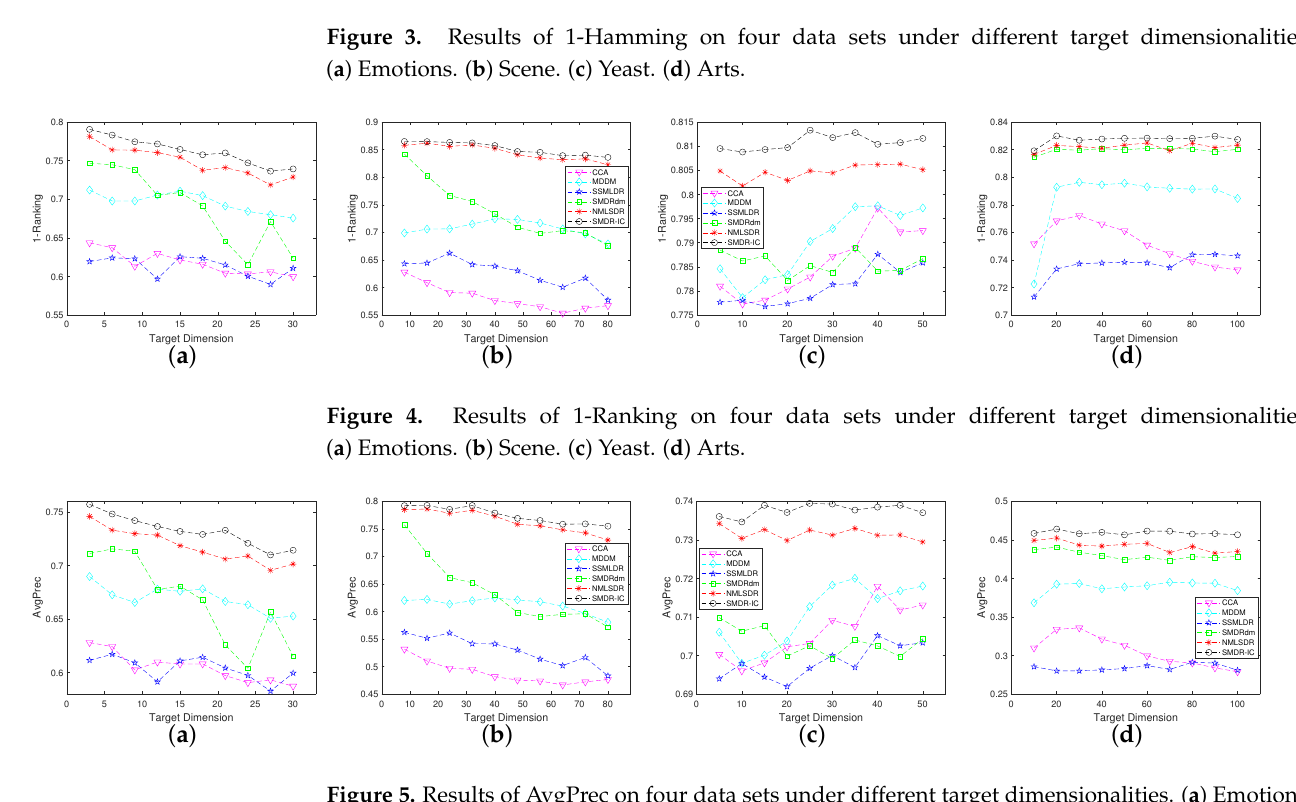
Figure 5. Results of AvgPrec on four data sets under different target dimensionalities. ( a ) Emotions. ( b ) Scene. ( c ) Yeast. ( d ) Arts.